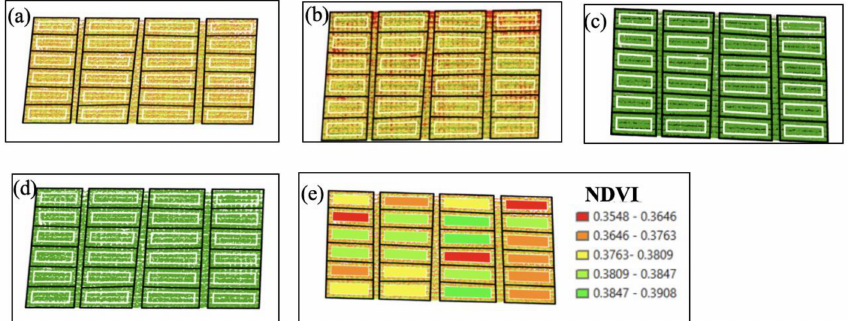
Figure 2. The experimental field at the early leaf stage: ( a ) black boxes indicate experimental plots, and white boxes within the black boxes indicate the bu ff er area for each plot and for two middle rows, manually; ( b ) boxes indicate NDVI for all pixels and plots; ( c ) manually, non-plant pixels were removed from the image using reclassification; ( d ) non-plant pixels were excluded by multiplying ( c ) by ( b ) to obtain the NDVI image just for plant pixels; ( e ) NDVI values for each plot (average of two middle rows) in the field, in this photo, zonal statistics (spatial analyst) in Arc GIS is shown in this photo to di ff erentiate the experiment plots, automatically. In our study, we used zonal statistics as a table to obtain the means values. The same procedure was done for all passive vegetation indices and plant